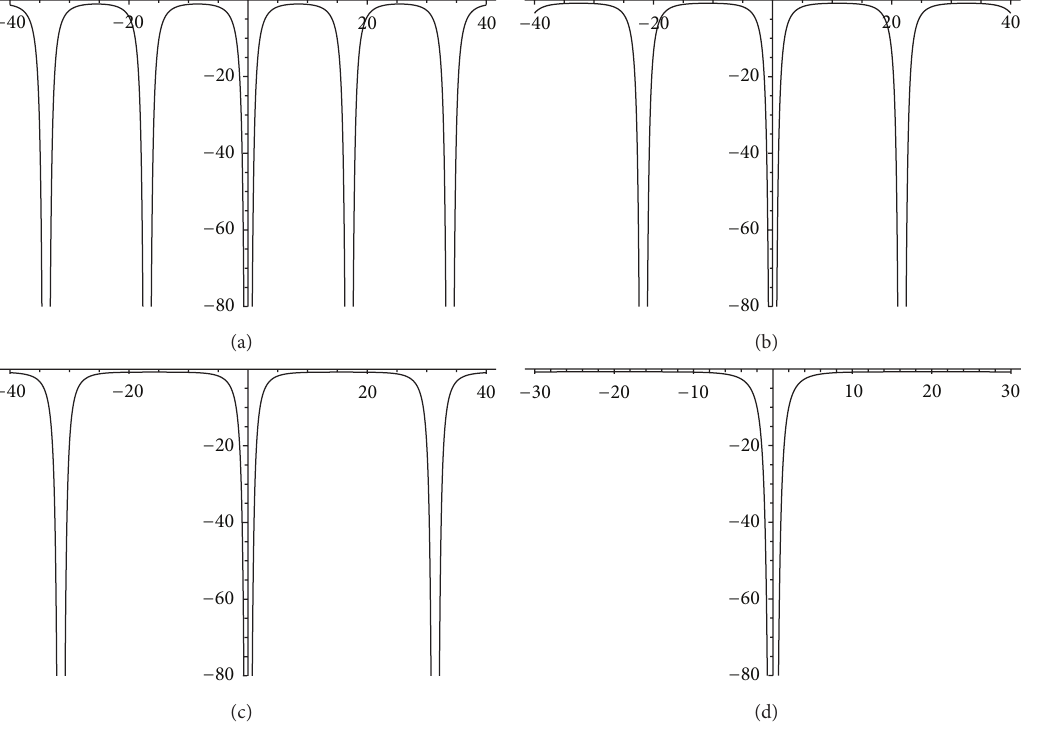
Figure 3: The varying process for graphs of 𝑢 5 (𝜉) when 𝑐 > 𝛼 and 𝑔 → 𝑔 0 − 0 where 𝛼 = 𝛽 = 𝛾 = 1 , 𝑐 = 2 , and (a) 𝑔 = 𝑔 0 − 10 −1 . (b) − 10 −2 . (c) 𝑔 = 𝑔 − 10 −4 . (d) 𝑔 = 𝑔 − 10 −6 . 𝑔 = 𝑔 0 0 0